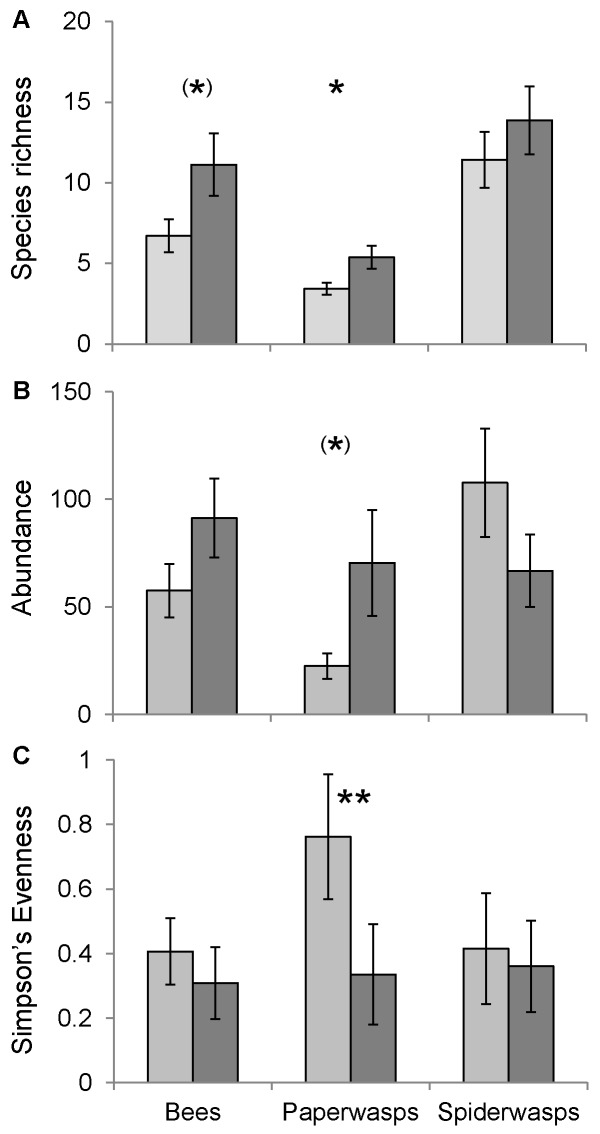
Biodiversity of bees and wasps.Differences in (A) species richness (mean no. of species per study site), (B) abundance (mean no. of collected individuals per site), and (C) Simpson’s Evenness per site for bees, paper wasps, and spider wasps between protected forest (light grey) and heterogeneous farmland (dark grey). Error bars show standard error of the mean. Significance levels: ** p<0.01, * p<0.05, (*) p<0.1.